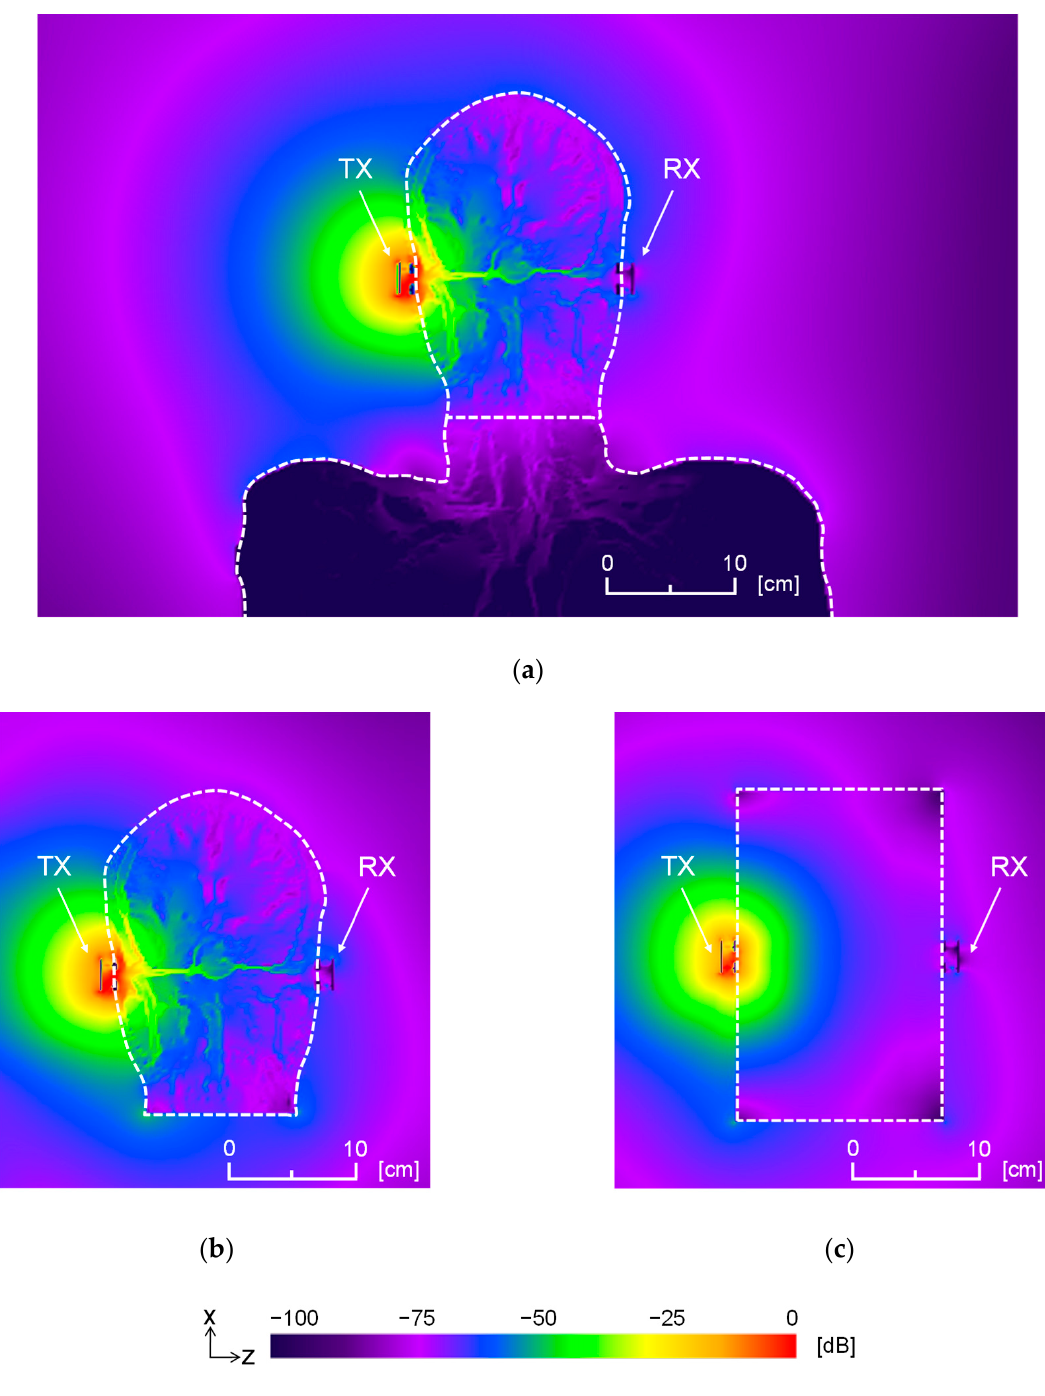
Figure 6. Electric field distributions around and inside the human body models: ( a ) whole-body human model; ( b ) detailed head model; ( c ) homogenous head model Table 2. Analysis results of the two ‐ electrode transceiver: impedances and transmission charac ‐ teristics S 21 under each simulation condition.